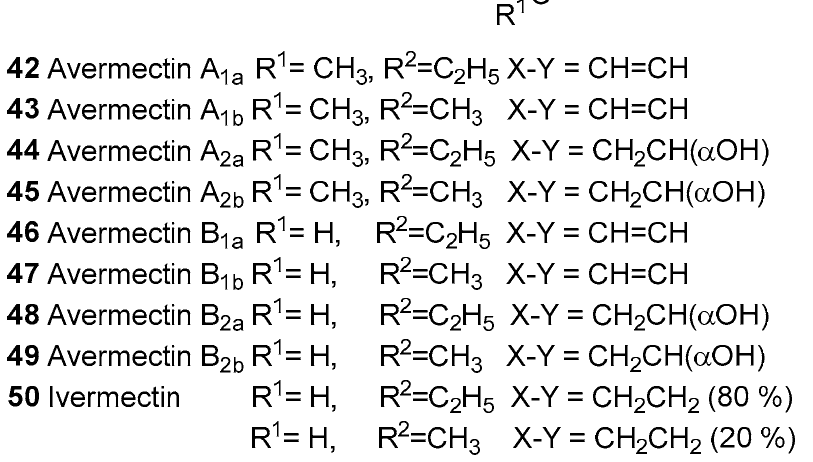
Figure 15. Avermectins and ivermectin [90]. The glycoside side chain is attached to C-13. Additional anthelmintic macrolactones, the milbemycins, were found in the growth medium of S.hygroscopicus . The milbemycins possess the same macrocyclic lactone skeleton as avermectins but are not oxygenated at C-13 and consequently they are not glyco- sides